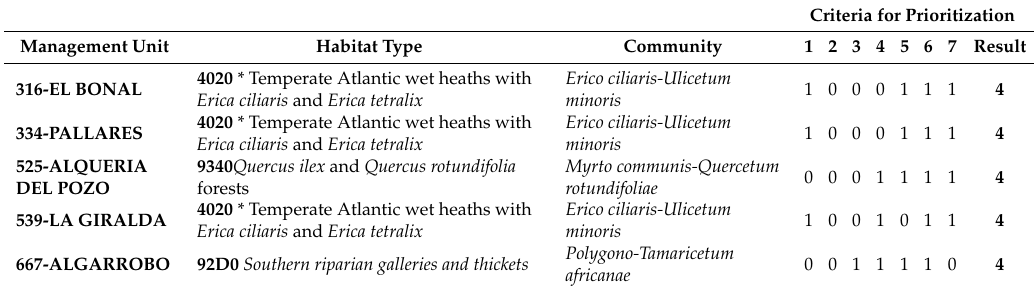
Table 7. Patches with prioritization level 1 and values assigned for each